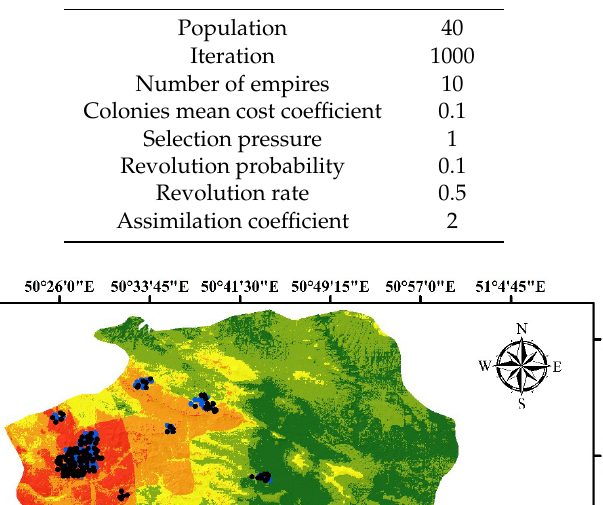
Figure 14. FFSM using the RBF-ICA model.